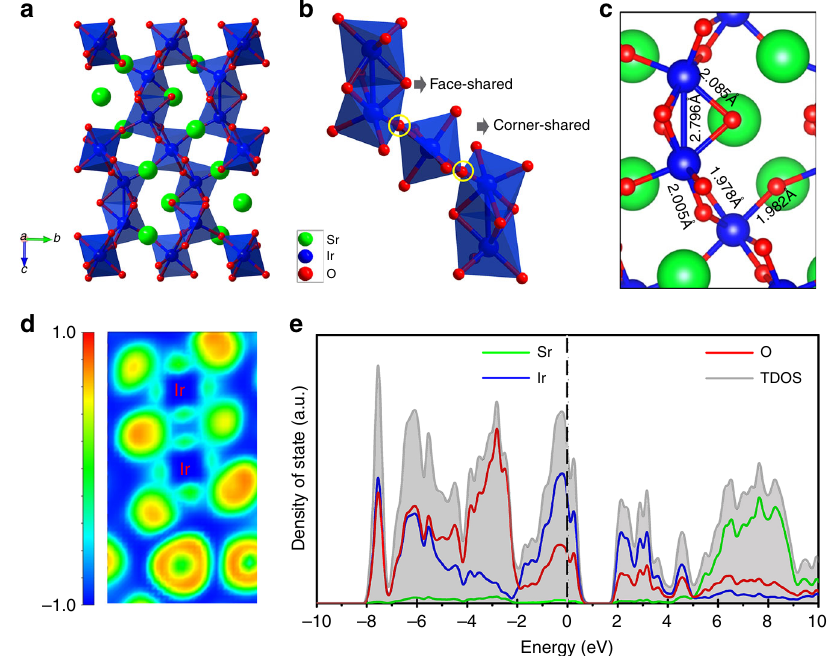
Fig. 1 Crystal structure and electronic structure of 6H-SrIrO 3 . a Crystal structure of 6H-SrIrO 3 . b A local connection pattern of IrO 6 octahedra, in which face-sharing IrO 6 octahedral dimers and corner-sharing, isolated IrO 6 octahedron are shown. c Local ball-and-stick model of 6H-SrIrO 3 , in which typical Ir – Ir and Ir – O bond lengths are presented. d Plot of electron location function for Ir – Ir bonding in 6H-SrIrO 3 . e Density of states of 6H-SrIrO 3 , in which the Fermi level is 0